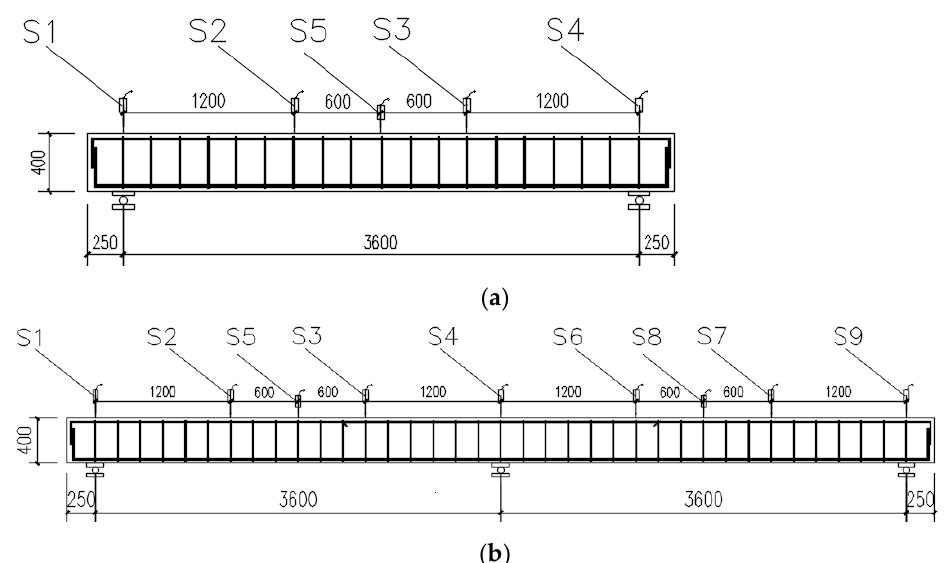
Figure 4. Arrangements of temperature measuring points: ( a ) Schematic diagram of measuring points; ( b ) real map of measuring points.